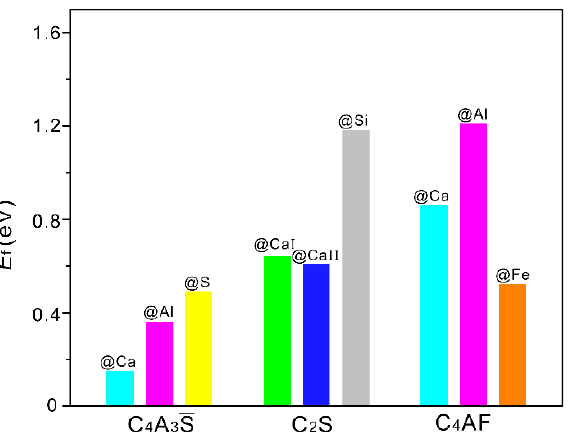
Figure 2. The normalized defect formation energies ( E f ) of configurations with Pb introduced at different sites.